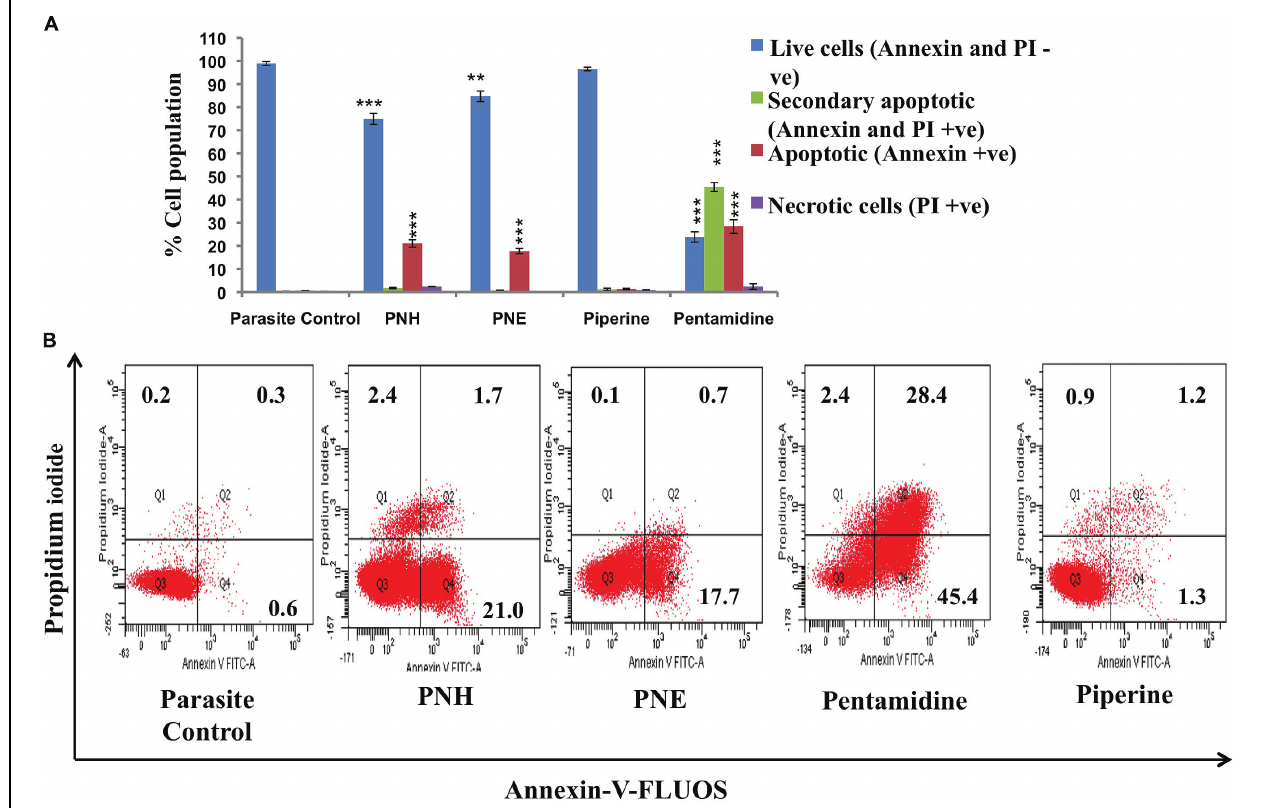
FIGURE 1 | Visualization of PS exposure. (A) Promastigotes (2 × 10 6 ml − 1 ) after treatment with test fractions and compounds (500 μ g ml − 1 ) for 72 h at 22 ◦ C were co-stained with Annexin-V-FLUOS and PI. The bar graph depicts percentages of live, apoptotic, secondary apoptotic and necrotic cells for different test samples. ∗∗∗ P < 0.001 and ∗∗ P < 0.01 with respect to parasite control. (B) FL-1 ( x -axis) vs. FL-2 ( y -axis) dot plots depicting live (both annexin and PI negative, lower left quadrant), necrotic (PI positive, upper left quadrant), apoptotic (annexin positive, lower right quadrant) and secondary necrotic (both annexin and PI postive) Leishmania